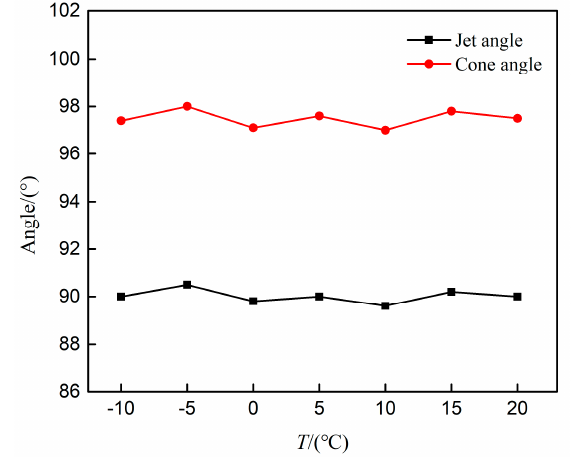
Figure 10. Jet angles and cone angles of different fuel temperatures (Case A).